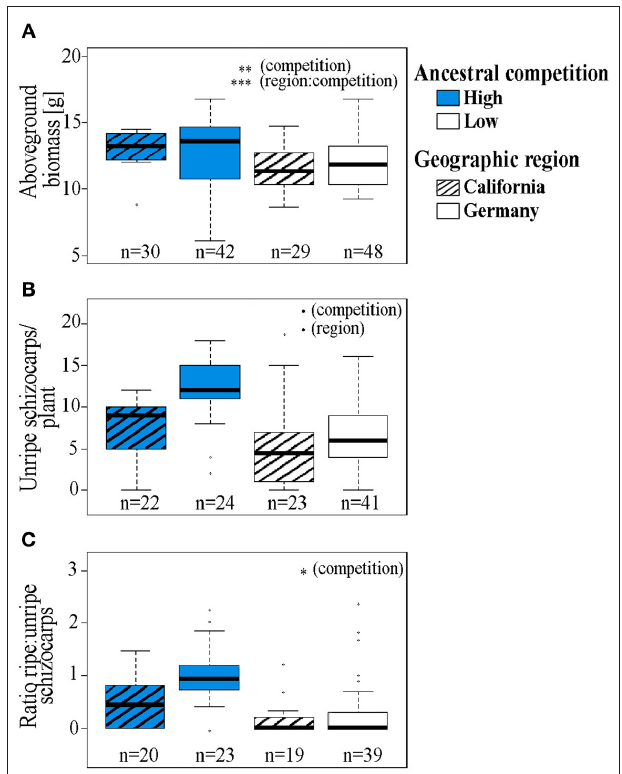
FIGURE 2 | (A) Aboveground fresh biomass, (B) number of unripe (green) schizocarps at harvesting, and (C) ratio of ripe to unripe schizocarps produced until harvesting of Erodium cicutarium plants (2nd laboratory generation). Data are shown for two geographic areas of seed origin: California, USA (hatched boxes) and Bavaria, Germany and two levels of ancestral competition: high (blue boxes), and low. The box and whisker plots show the median (horizontal line), quartiles (boxes), 5 and 95% percentiles (whiskers), and outliers of each data set (open circles). Levels of significance: *** p < 0.001, ** p < 0.01, * p < 0.05, • p < 0.1, p > 0.01, not significant. The results of statistical analyses are displayed in Table 2